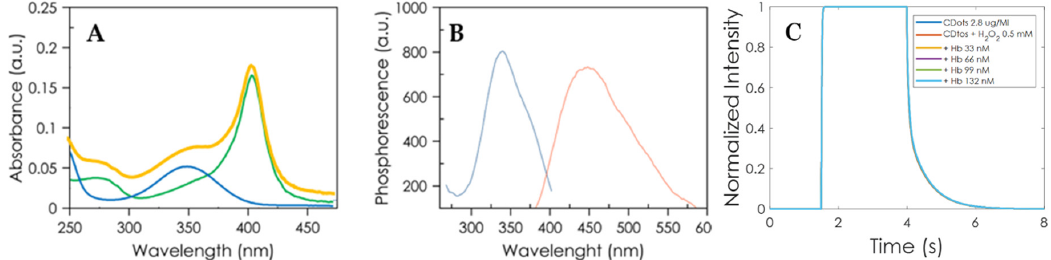
Figure 4. ( A ) UV spectra of CD solution (2.8 × 10 − 3 mg · mL − 1 CDs, blue line), Hb solution (0.5 µ M Hb, green line), and CDs/Hb solutions (yellow line), all in 0.02 M NaH 2 PO 4 /Na 2 HPO 4 (pH = 4.7) buffer. ( B ) Room temperature phosphorescence spectra of CD solution (2.8 × 10 − 3 mg · mL − 1 CDs), blue line excitation spectrum and red line emission spectrum. ( C ) Normalized photoluminescence decay for different Hb concentrations. The offset of the curves was removed.